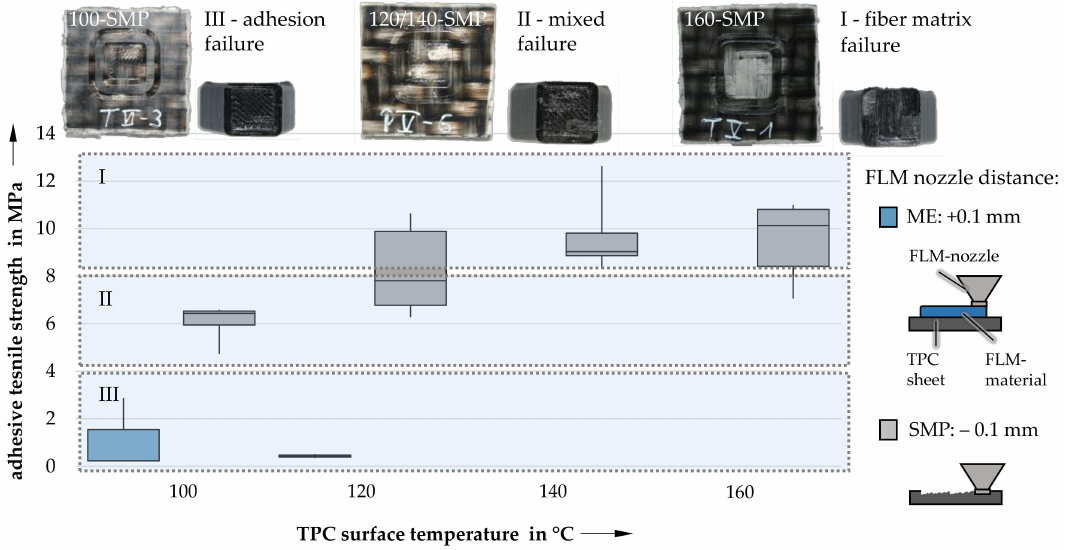
Figure 6. Bonding strengths as a function of TPC surface temperature.